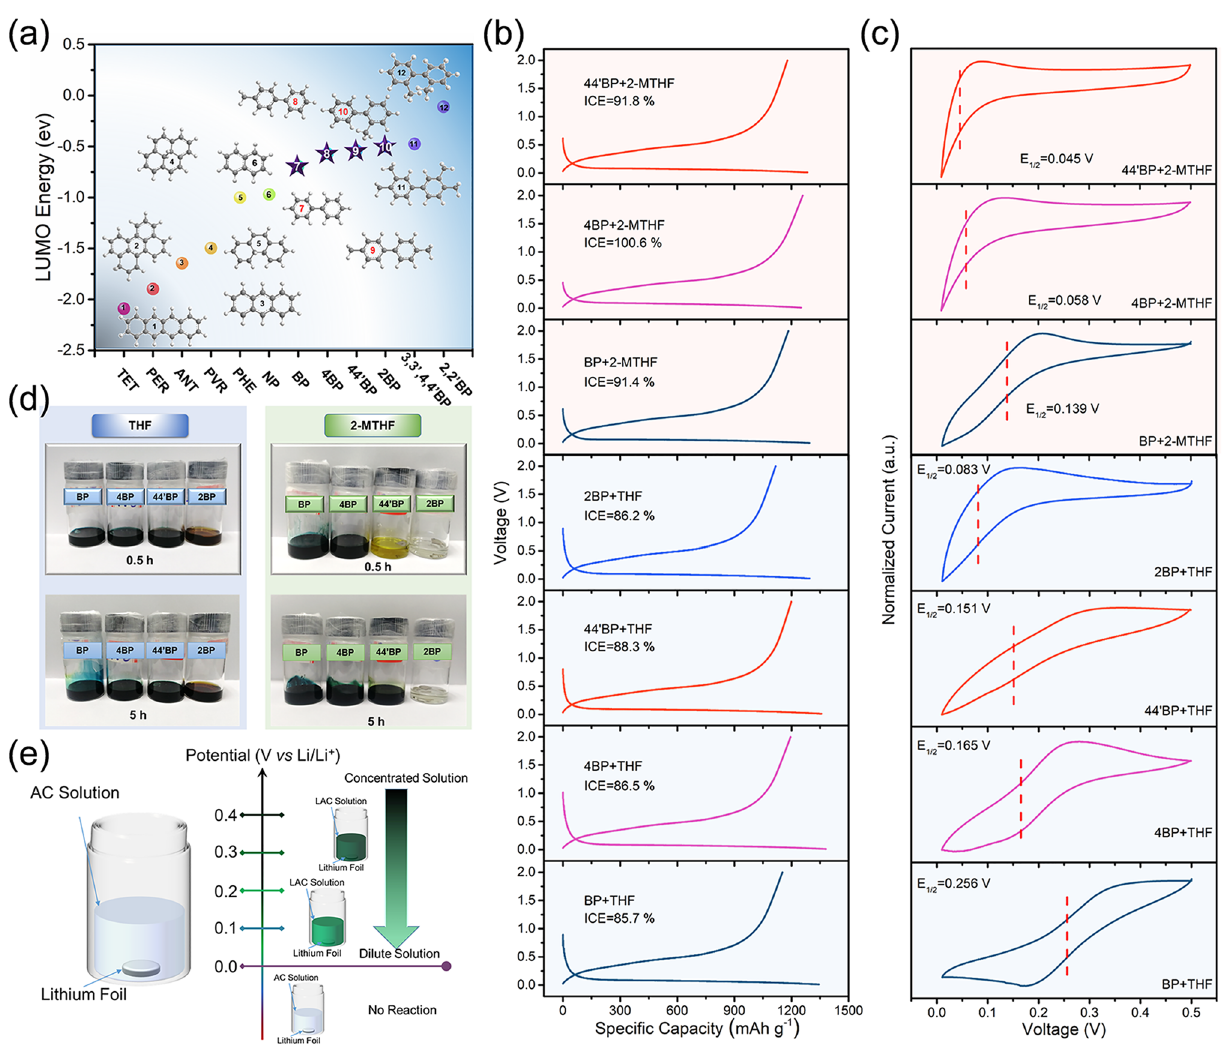
Fig. 2 a LUMO energies of different arenes. b Initial discharge–charge profiles of p-SiO/C anodes immersed in different prelithiation reagents. c CV curves of Cu electrode in different 0.1 M LAC reagents containing 1 M LiPF 6 at 20 mV s −1 . d Digital photographs of the color change of LAC reagents. e Schematic diagram of the reaction possibility between lithium metal and AC